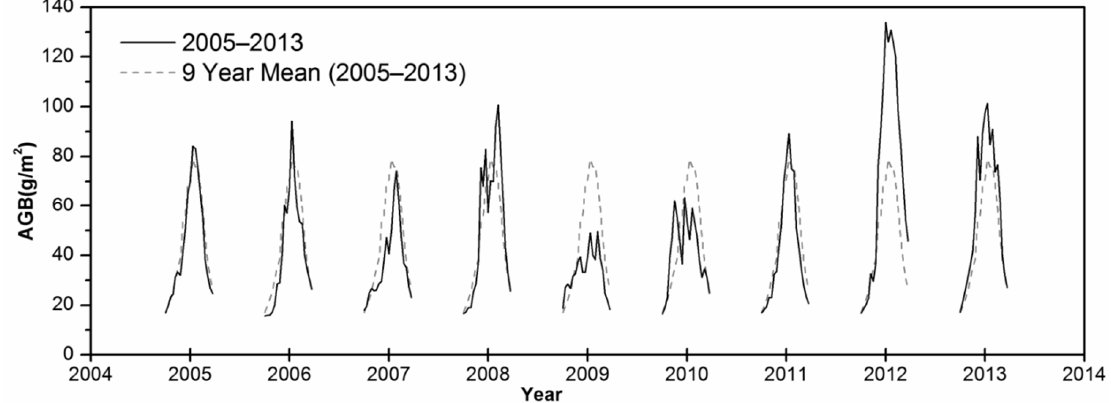
Figure 7. The 8-d intervals of the regional mean biomass estimated based on synthetic NDVI and SVM-AGB model during the growing season (May to September) of 2005–2013 in Xilinhot. Dash line represents the regional mean biomass of 9-yr mean (2005–2013).